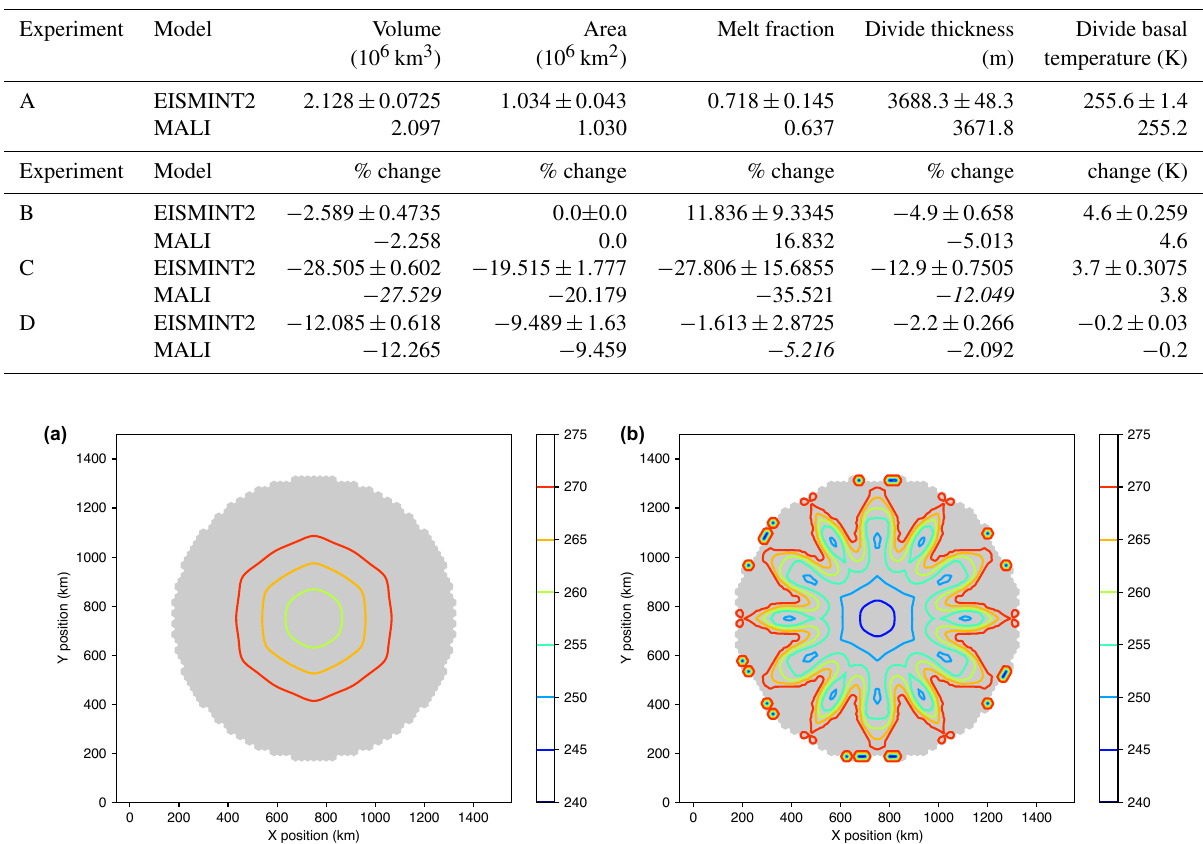
Table 3. EISMINT2 results for MALI shallow ice model. For each experiment, the model name EISMINT2 refers to the mean and range of models reported in Payne et al. (2000), and we assume that the range reported by Payne et al. (2000) is symmetric about the mean. For experiments B, C, and D reported values are the change from experiment A results. MALI results that lie outside the range of values in Payne et al. (2000) are italicized.